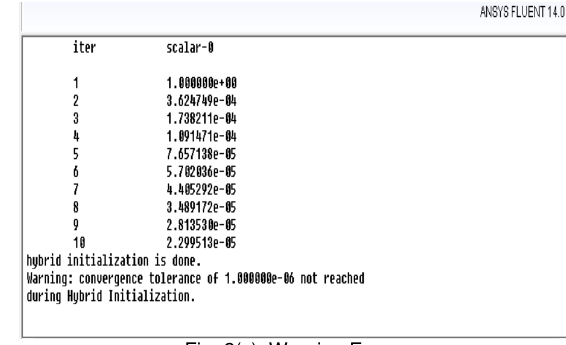
Fig. 2(b): X-Momentum Error